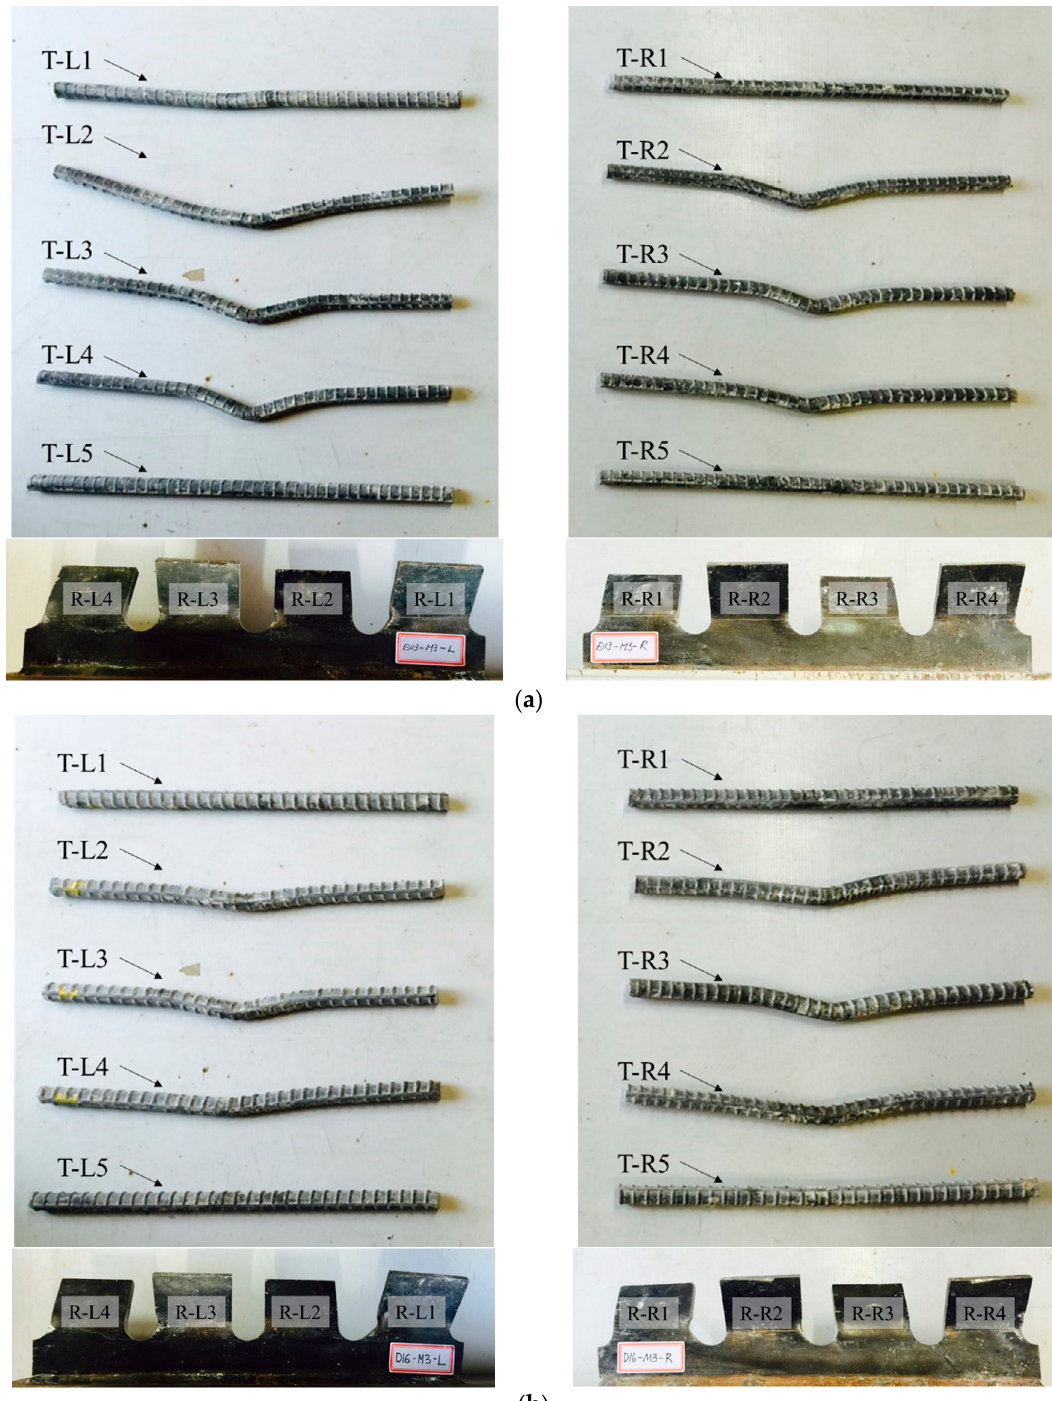
Figure 12. Deformation of transverse rebars and ribs; Stage 5: ( a ) SY-D13-M3; ( b ) SY-D16-M3.